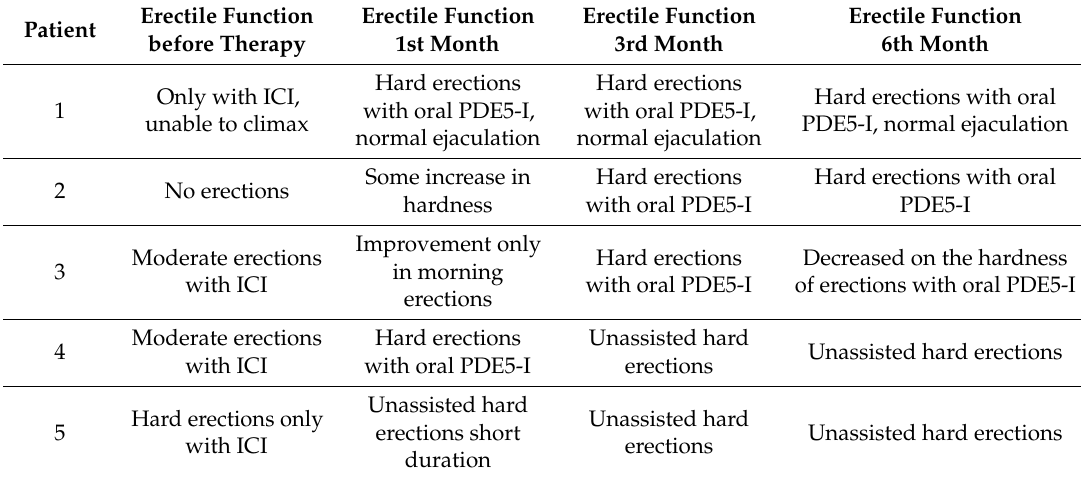
Table 5. Erectile